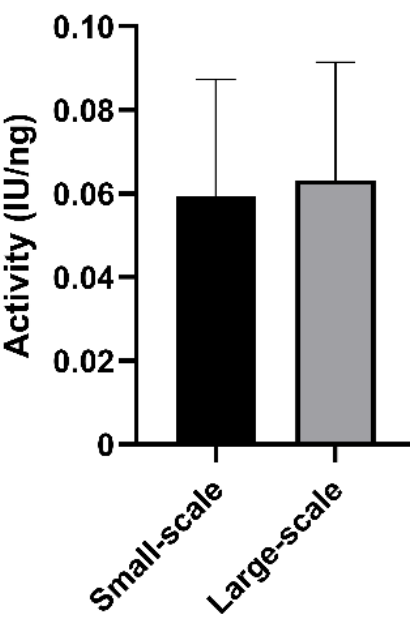
Table 2. rADAMTS13 protein purified from flasks via V5 or QFF +